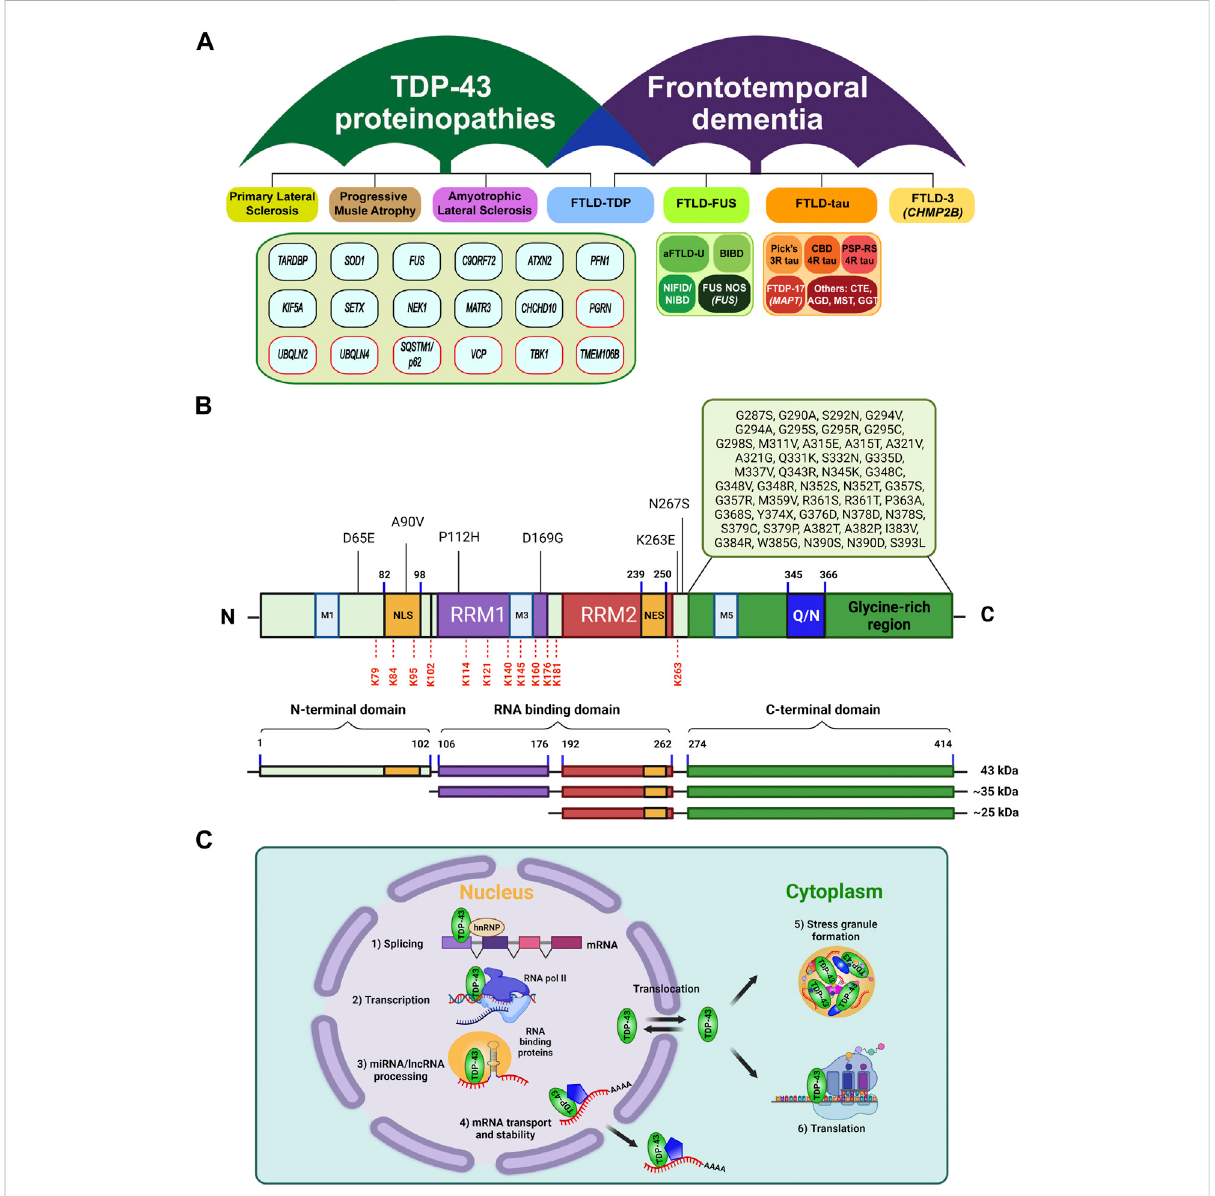
FIGURE 1 Classi fi cationofTDP-43proteinopathies,anditsstructuralfeaturesandgeneralfunctions. (A) UmbrelladiagramofTDP-43proteinopathiesand frontotemporal lobar degeneration (FTLD) that are classi fi ed by neuropathy types and causal genetic factors or pathological signature factors (modi fi ed from Prasadet al., 2019 and Hofmann et al., 2019). Genes in red boxes highlight the UPS or autophagy components. Note that the genetic factors under TDP-43 proteinopathies were primarily identi fi ed from ALS and FTLD-TDP. (B) Structural organization of TDP-43. TDP-43 is composed of an N-terminal domain (NTD) with a nuclear localization signal (NLS), two RNA-recognition motifs (RRM1, RRM2) with a nuclear export signal (NES) inRRM2, and aglycine-rich C-terminal domain(CTD) containingaglutamine/asparagine-rich region (Q/N).Approximately50 missense mutations were located in the glycine-rich region of CTD (Buratti, 2015; Harrison and Shorter, 2017). Under pathological conditions, the full length TDP-43 can undergo truncation into the C-terminal fragments of 35 kDa or 25 kDa via caspase or calpain (Zhang et al., 2009; Xiao et al., 2015; Berning and Walker, 2019). In addition, a number of ubiquitination sites in TDP-43 have been reported, including K79, K84, K95, K102, K114, K121, K140, K145, K160, K176, K181, and K263, which are marked in red dash lines (Kim et al., 2011; Dammer et al., 2012; Kametani et al., 2016; Hans et al., 2018). (C) TDP-43 is mainly localized in nucleus where it performs multiple functions relating to RNA metabolic pathways, including 1) mRNA splicing, 2) transcription, 3) miRNA biogenesis, and lncRNA processing. Also, it shuttles between nucleus and cytoplasm, where it participates in 4) & 6) mRNA transport, stability, protein translation, and 5) stress granule